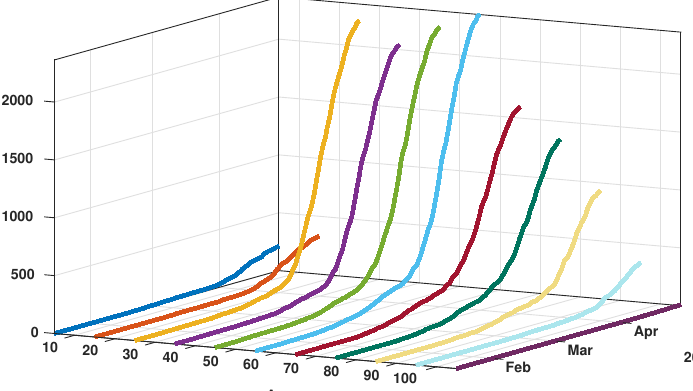
Figure 5. Time evolution of the cumulative number of reported cases of SARS-CoV-2 per age class. The vertical axis represents the total number of cumulative reported cases in each age